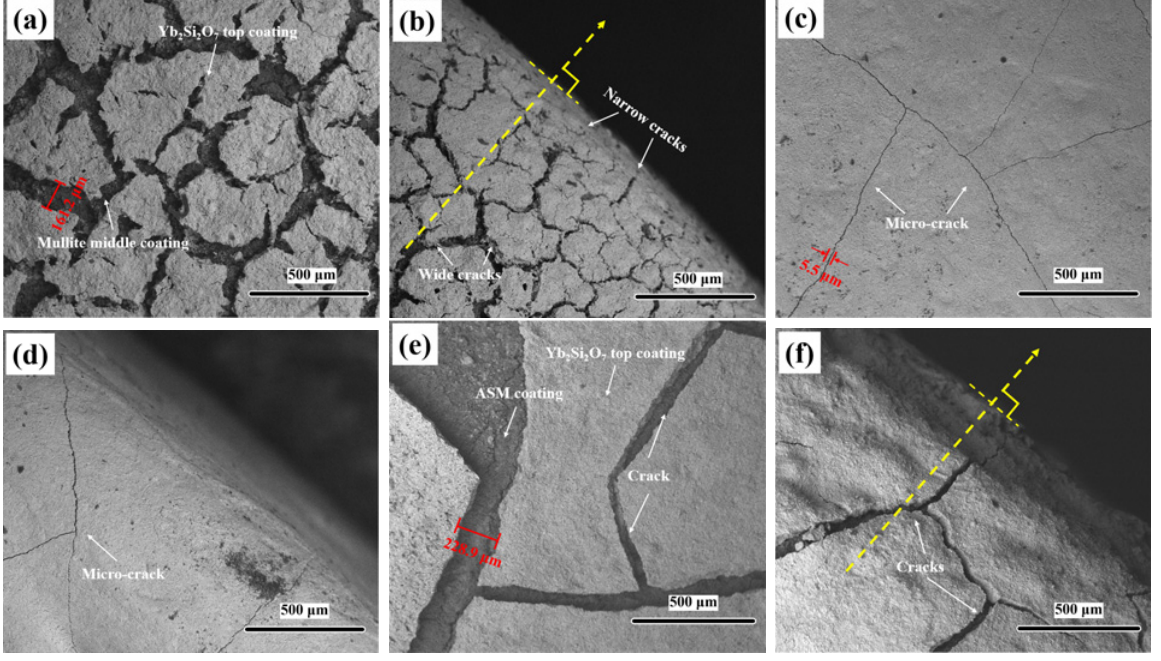
Fig. 8 Surface microstructures of (a, b) tri-layer Yb 2 Si 2 O 7 /mullite/SiC, (c, d) Yb 2 Si 2 O 7 /SM/SiC, and (e, f) Yb 2 Si 2 O 7 /ASM/SiC coatings-coated C f /SiC samples after 360-min corrosion in the burner rig test at 1673